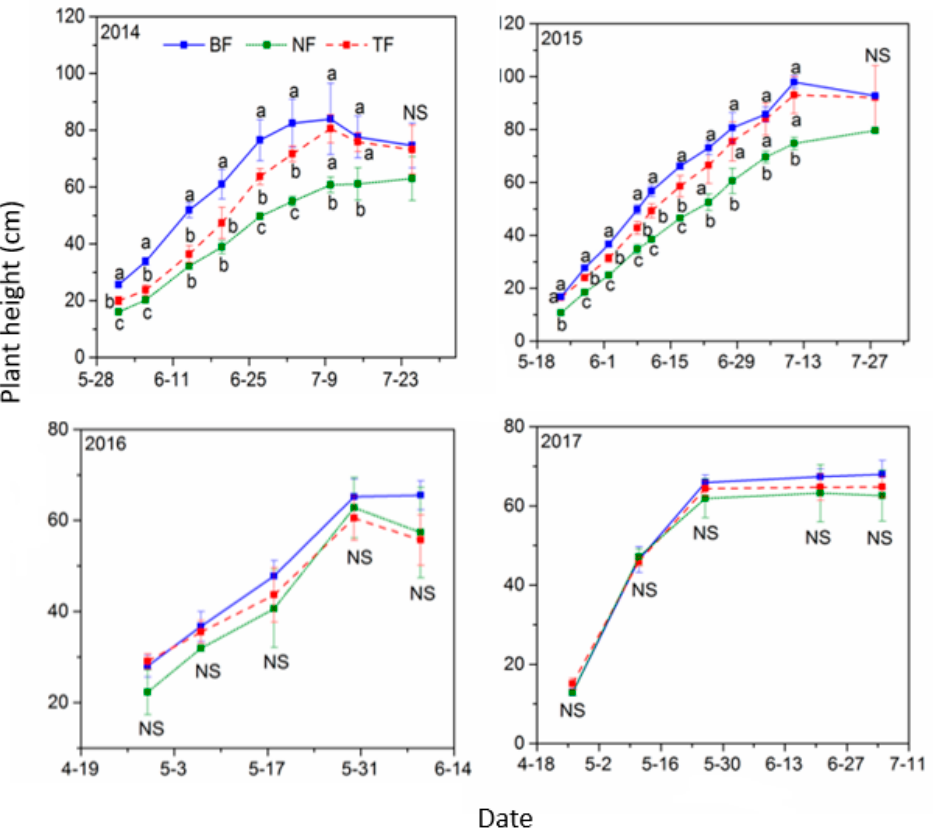
Figure 6. Plant height of potatoes grown with black film (BF), no film (NF), and transparent film (TF) in 2014–2017. (Graphs of plant heights in 2014 and 2015 were according to Zhang et al., 2017b). Note: “NS” meant values of different treatments were not significantly different by F-test ( p > 0.05). Table 5. Potato tuber fresh weight of 10 plants sampled from black film (BF), no film (NF), and transparent film (TF) treatment in 2014–2017.